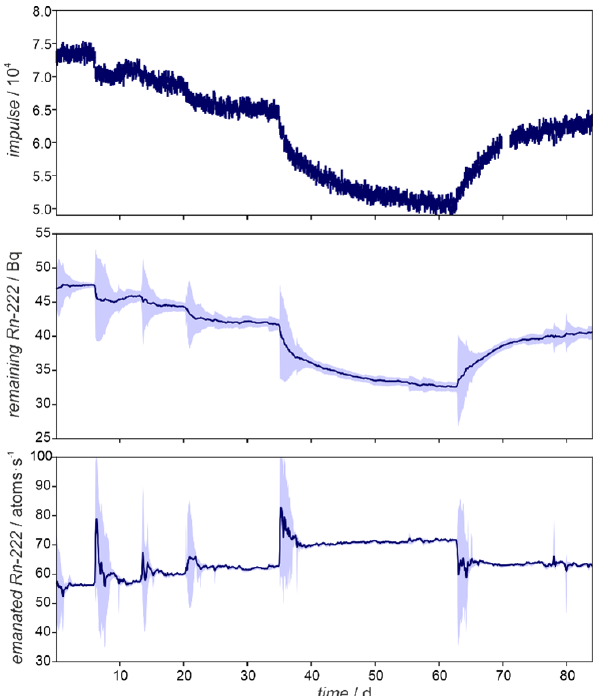
Figure 1. The first (upper) diagram shows the integral count rate above the highest energy of 226 Ra of an electrodeposited source, which is the input data to the algorithm. The variation of this count rate is achieved by variation of environmental parameters, specif- ically, the relative humidity. The second diagram presents the re- maining 222 Rn activity in the source, given in Bq, inferred from the count rate data. The light blue area represents the 90% confi- dence interval for the uncertainty of the measurements. The third diagram gives the primary desired result, which is the emanated number of 222 Rn atoms, represented as atomss − 1 . Upon changes in the emanation, the confidence intervals increase, since the in- ference can then only be carried out using few data points. Within stable regimes, as time goes on, more data becomes available, such that the confidence intervals continually